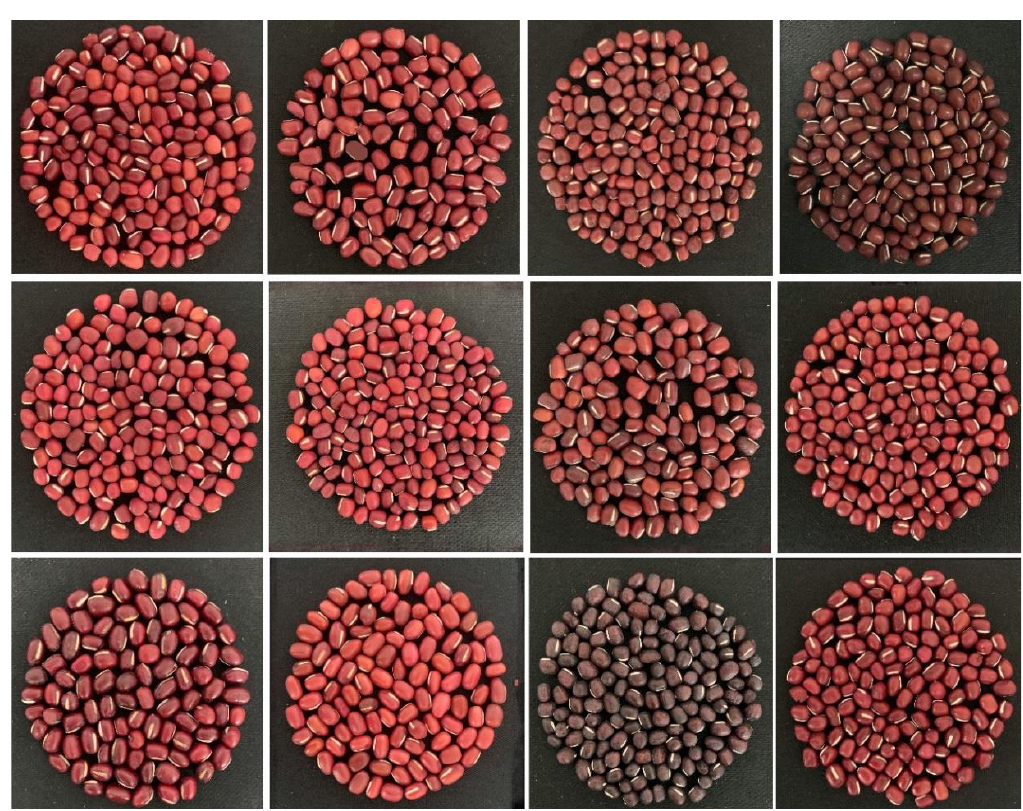
Figure 1. Grain photos of the tested adzuki bean varieties.